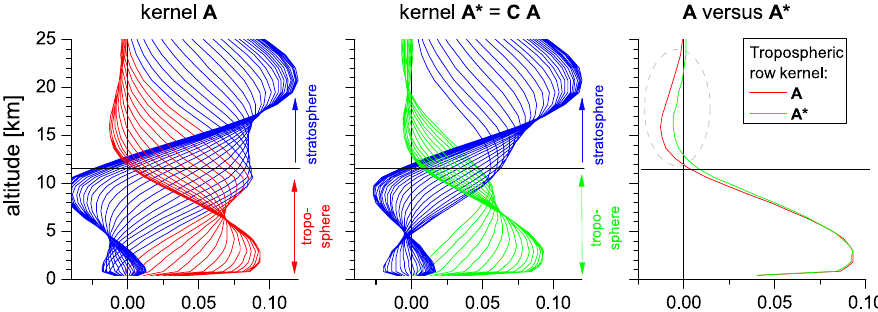
Figure 4. Row averaging kernels of the CH 4 product for a typical observation at the subarctic site of Kiruna. Left panel: kernels ˆ A obtained from the Tikhonov–Phillips profile retrieval (red: tropospheric kernels, blue: UTLS kernels). Central panel: kernels A ∗ obtained after applying the a posteriori optimisation of Eq. (14) (green: tropospheric kernels, blue: UTLS kernels). Right panel: comparison of the surface row kernels ˆ A (red line) and A ∗ (green line). The typical altitude where the UTLS starts is indicated by the horizontal black line (11 . 5km).